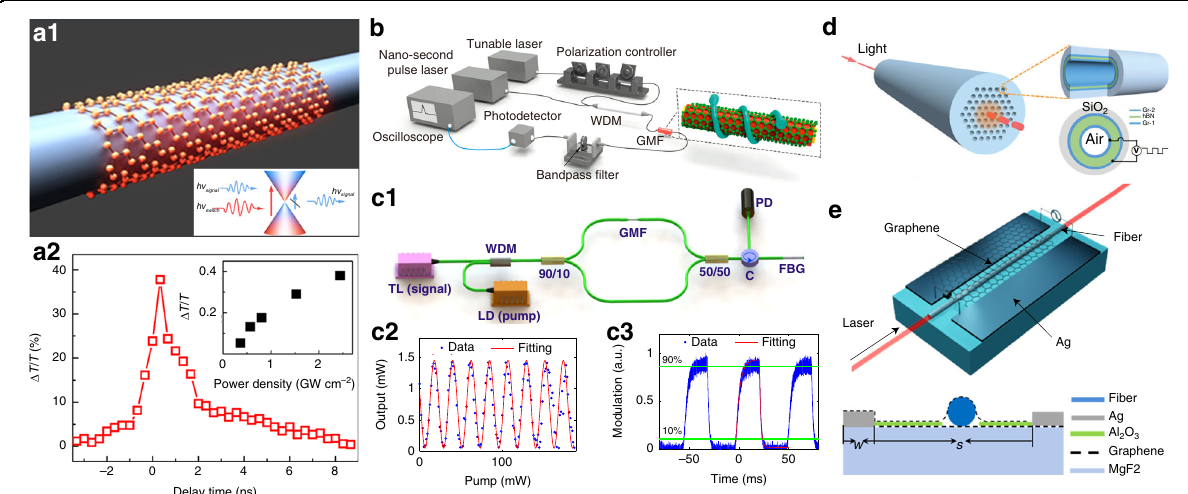
Fig. 5 Optical fi ber modulators integrated with 2D materials. a1 Schematic illustration of a graphene-coated micro fi ber (GMF) structure for all- optical modulator. Inset: Schematic describes Pauli blocking effect 56 . a2 Pump − probe delay time measurement results. Inset: Relation of the modulation depth and pump intensity 56 . b Measurement setup of the pump-probe system with a stereo graphene-MF device 58 . Experimental setup for measuring the phase shift in GMF ( c1 ), all-optical switching by a GMF ( c2 ), and temporal response of the all-optical switching ( c3 ) 57 . d Schematic sketch of a sandwiched graphene/hBN/graphene photonic-crystal- fi ber electro-optic modulator (EOM) 229 . e Schematic diagram of the MF-based EOM (upper panel) and its cross-section structure (lower panel) 227 . a1 – a2 Reproduced from ref. 56 with permission of ACS publications. b Reproduced from ref. 58 with permission of Springer Nature: Light: Science & Applications. c1 – c3 From ref. 57 . Reprinted by permission of OSA Publishing. d Reproduced from ref. 229 with permission of The Royal Society of Chemistry. e Reprinted from ref. 227 by the permission of IEEE